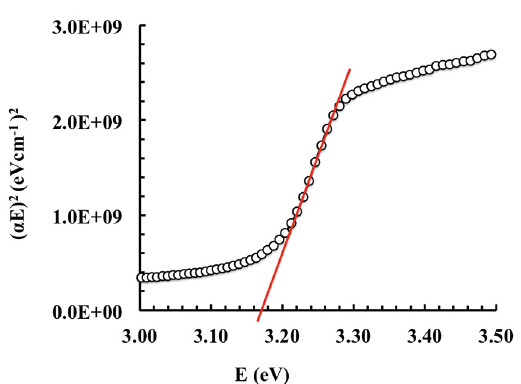
Figure 6. Tauc’s plot obtained through the application of the formulas defined for general application of K-M method.